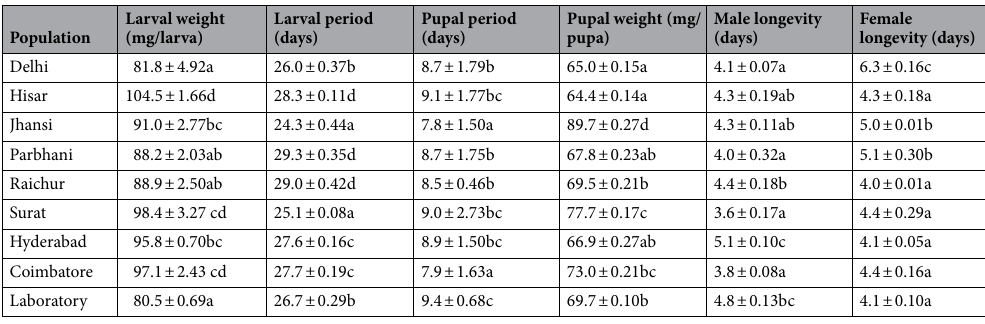
Table 1. Biological performance of Chilo partellus populations from different geographical regions under laboratory conditions. The values in a column following different letters are significant at P = 0.05 using post- hoc Tukey’s HSD